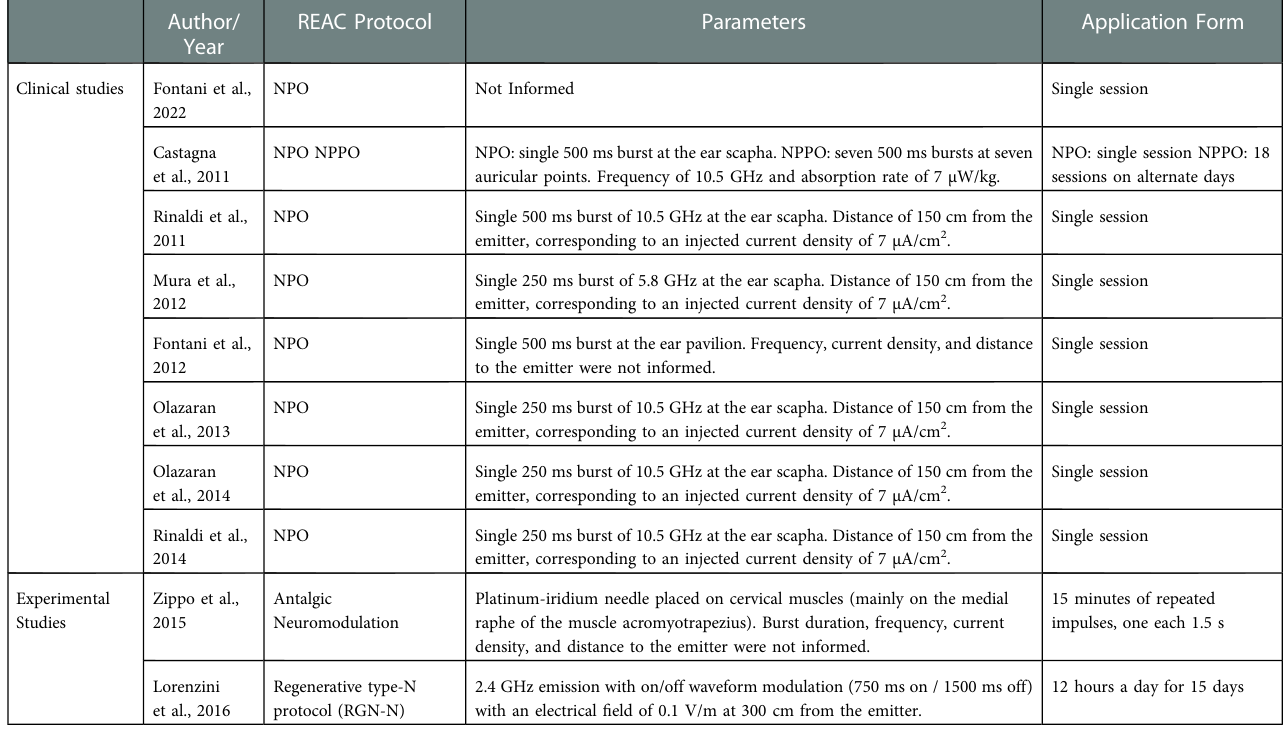
TABLE 5 REAC protocols and parameters used in the studies included in this integrative